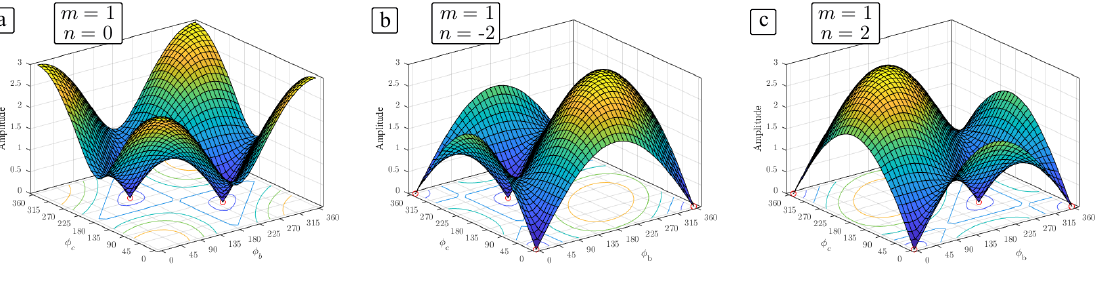
Figure 5. Evaluation of the Equation (9) to evaluate V nO ( m , n , φ b , φ c ) considering ( a ) m = 1, n = 0 ( b ) m = 1, n = − 2 ( c ) m = 1, n =